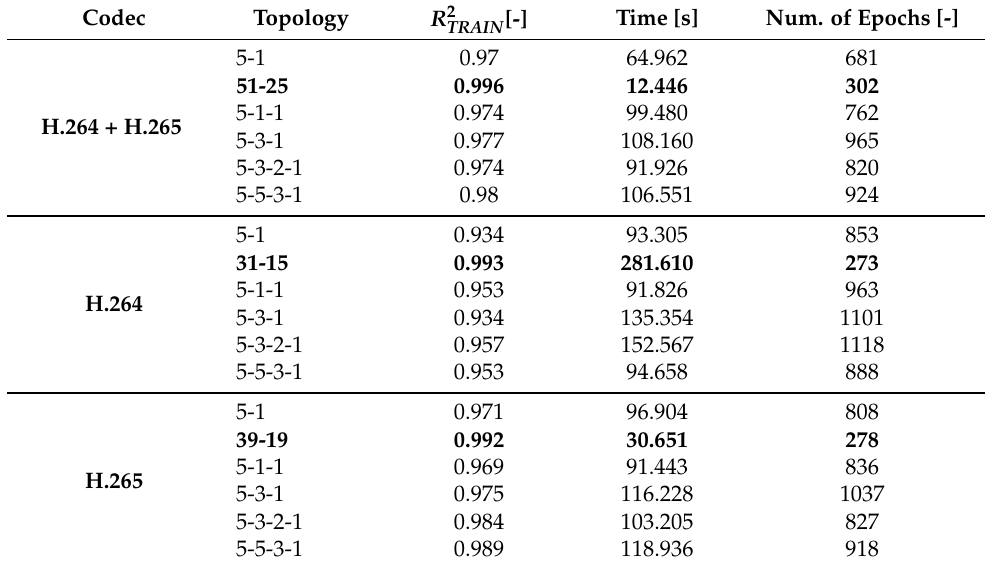
Table 4. The basic and the best topologies of the subjective prediction; Ultra HD.